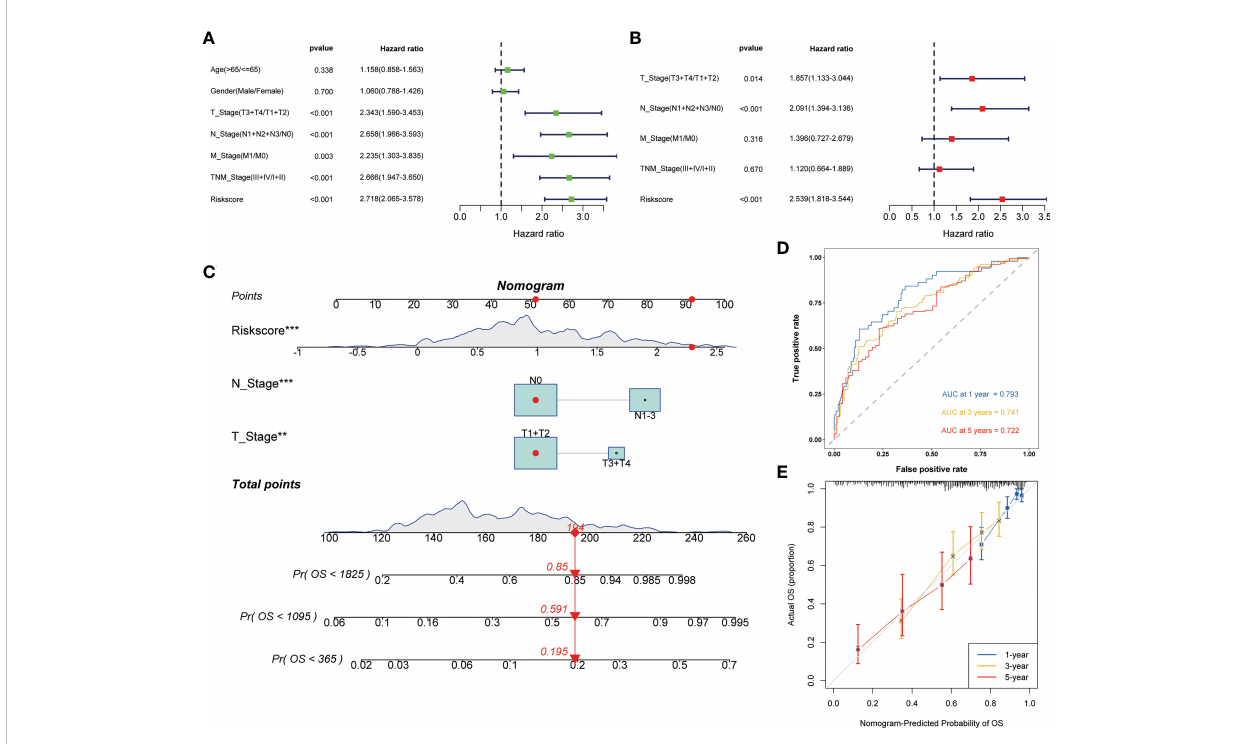
FIGURE 4 Construction of the nomogram to predict the prognosis of LUAD. Univariate (A) and multivariate (B) Cox regression analysis of risk score. (C) Nomogram for the prediction of 1-, 3- and 5-year survival probability. (D) Time-dependent ROC analysis of the nomogram. (E) Calibration curves for evaluating the accuracy. **p < 0.01, ***p <